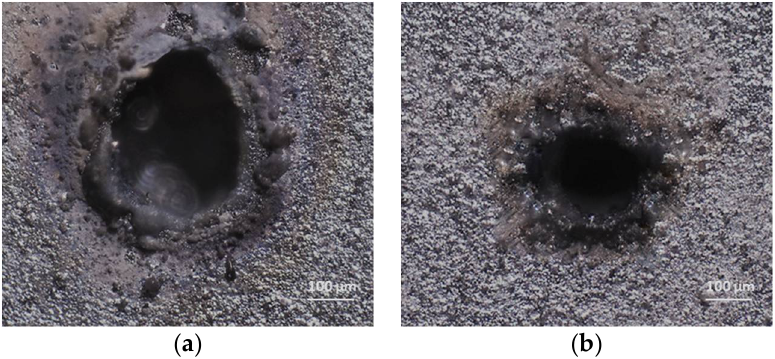
Figure 6. Micromachined cavities in smart ceramic materials using ( a ) the LBMM process, and ( b ) the LA-LBMM process under Distilled Water.